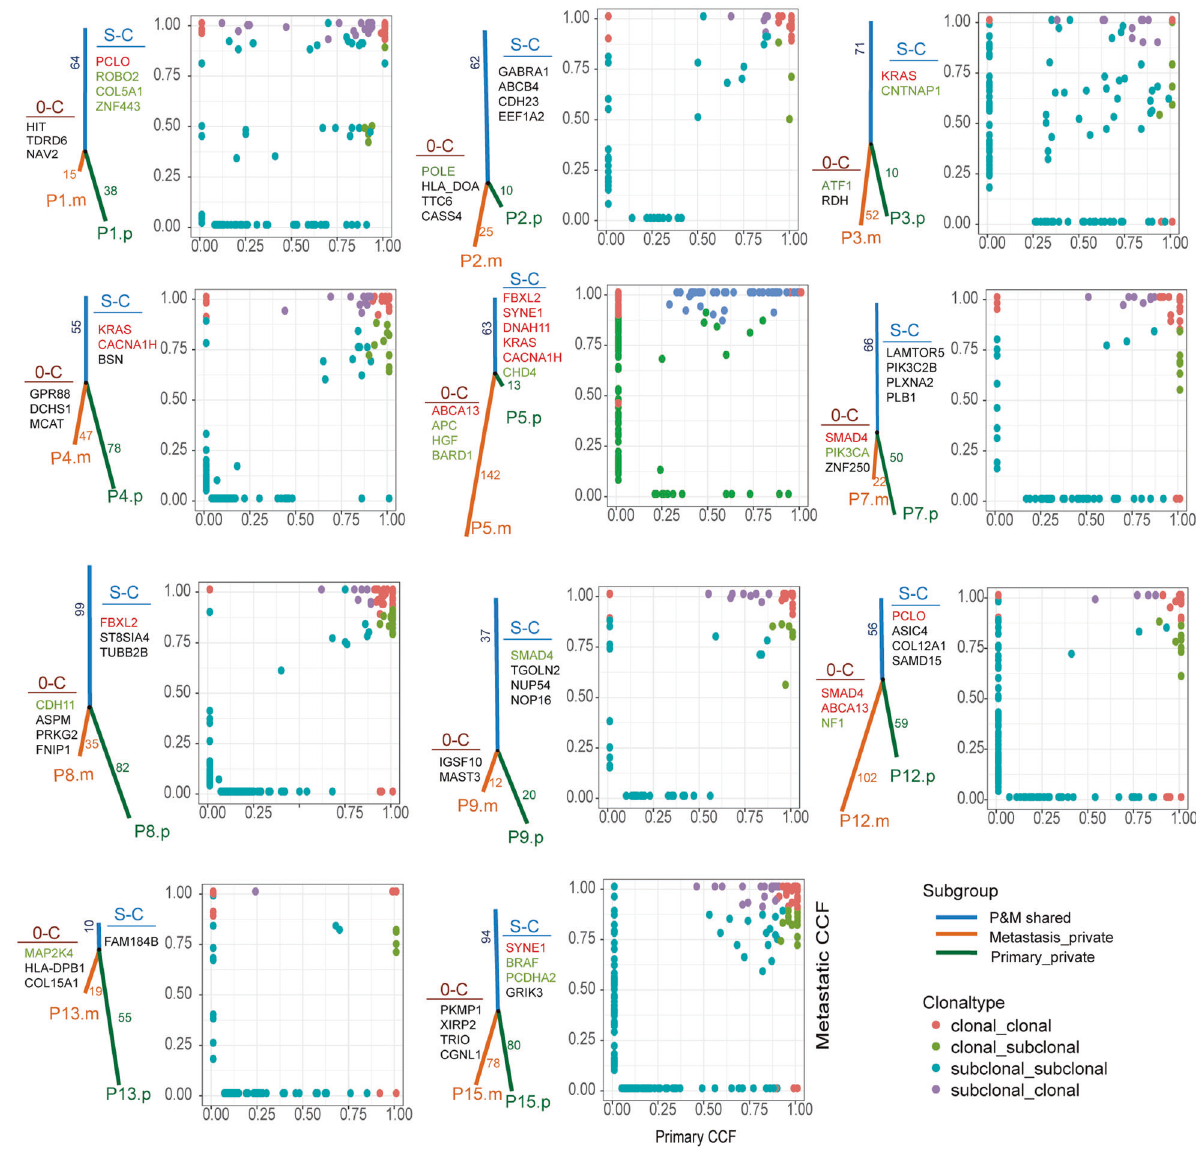
Fig. 2 Phylogenetic tree and scatter diagram showing clonal evolution in CLM. The left panel exhibited phylogenetic tree and the right panel exhibited scatter plot in each patient. On the phylogenetic tree, the trunk (blue) indicates mutation shared by both primary tumor and liver metastases, red branch indicates metastasis-private mutations and the green branch indicates primary-private mutations, and the number on trunk or branch indicate amount of corresponding mutations. S-C, subclonal-clonal clonal pattern, 0-C, none-clonal clonal pattern, the genes in green are driver genes and those in red are recurrently mutated genes. m metastasis, p primary. In the scatter diagram, X -axis indicates the mutational CCF value in primary tumor, Y -axis represents mutational CCF value in liver metastasis, spots with different colors indicate the clonal type from primary tumor to liver metastases: red, clonal_clonal; green, clonal_subclonal; blue, subclonal_subclonal; purple, subclonal_clonal. CLM colorectal liver metastasis, CCF cancer cell fraction. Immune cell micro-environment in CLM To explore if the immune-cell micro-environment affects CLM progress, we used RNA-seq to analyze the distribution of immune cells in normal, primary and matched liver metastatic tissues. The different proportions of immune cells including B cells, cancer associated fi broblasts, CD4 + T cells, CD8 + T cells, endothelial cells, macrophages in normal, primary and matched liver metastasis tissues re fl ect the different immune microenvironment status across stages of tumor progression (Fig. 6A). B cells were mainly enriched in normal tissues, while the number of B cells reduced signi fi cantly in liver metastases ( P < 0.001), indicating human immunity defects in liver metastases; primary tumor had the most cancer associated fi broblasts compared to normal and metastatic